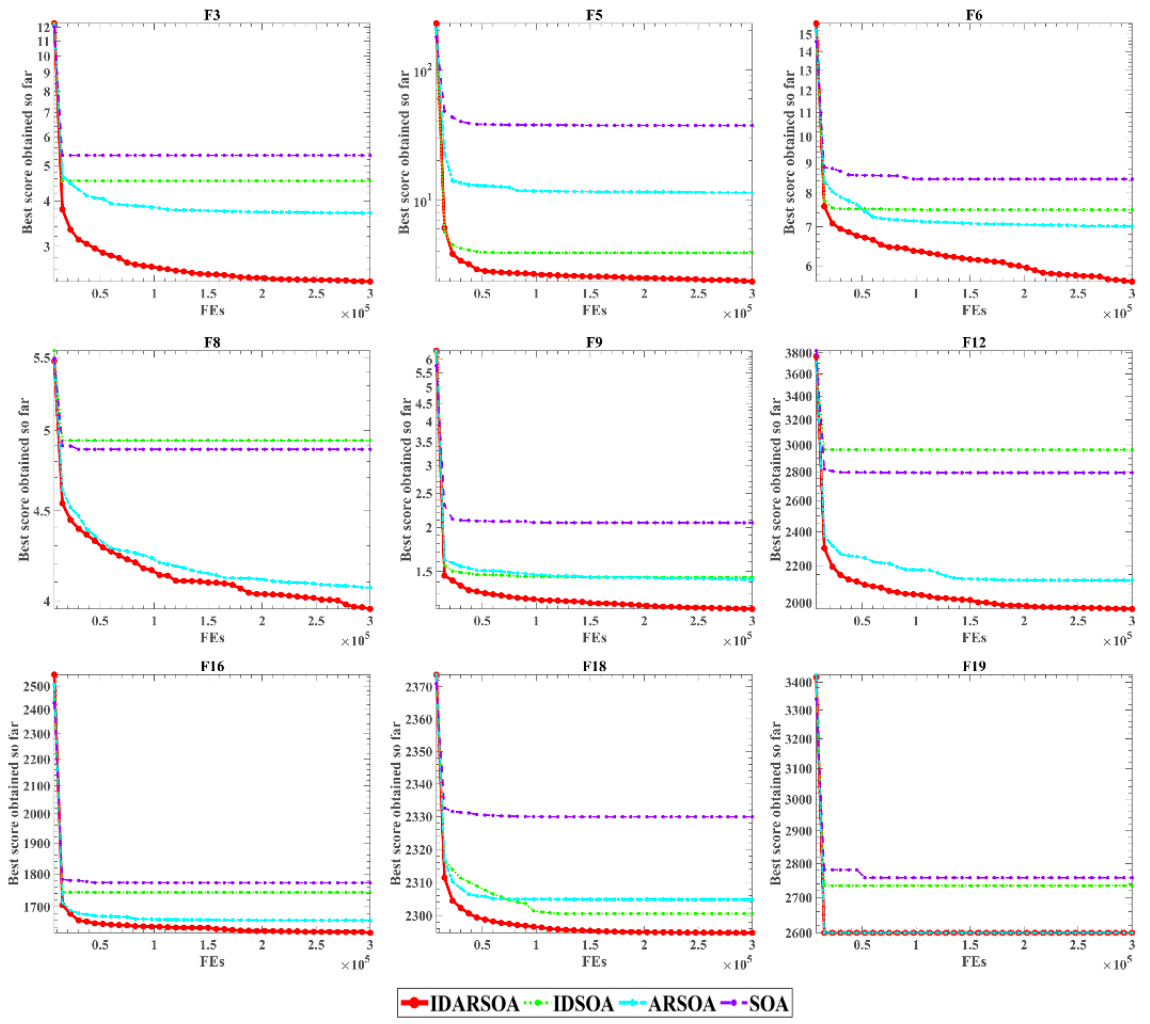
Figure 2. Comparison and convergence curve of mechanism.